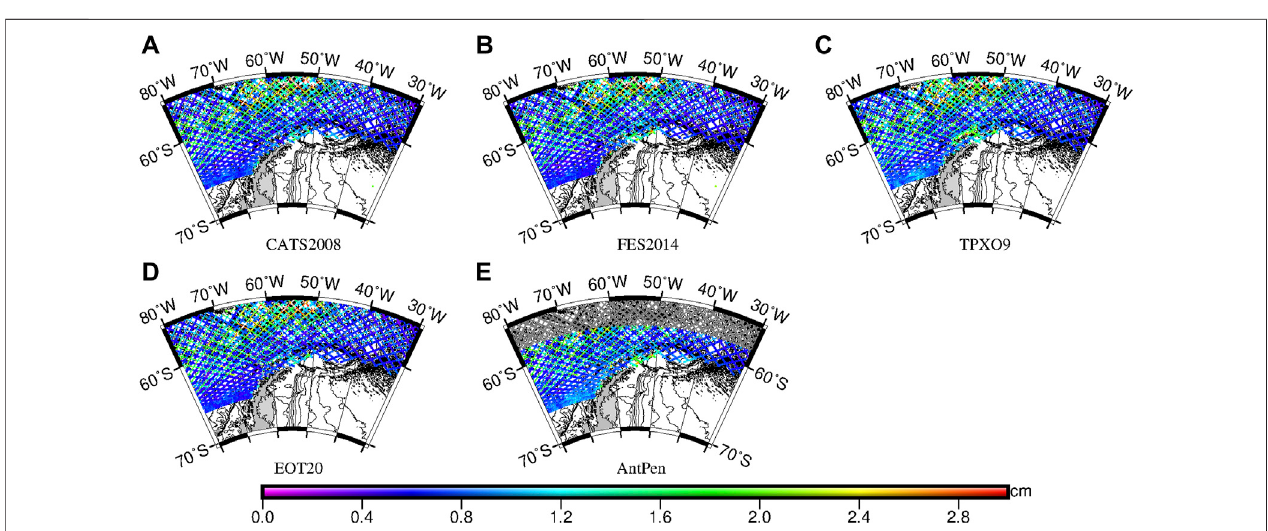
FIGURE 10 | RSS of each along-track point of (A) CATS2008, (B) FES2014, (C) TPXO9, (D) EOT20, and (E) AntPen in the Drake Passage, including original orbit (large points) and interleaved orbit (small points). Gray values in (E) are locations beyond the geographic coverage of the AntPen model.